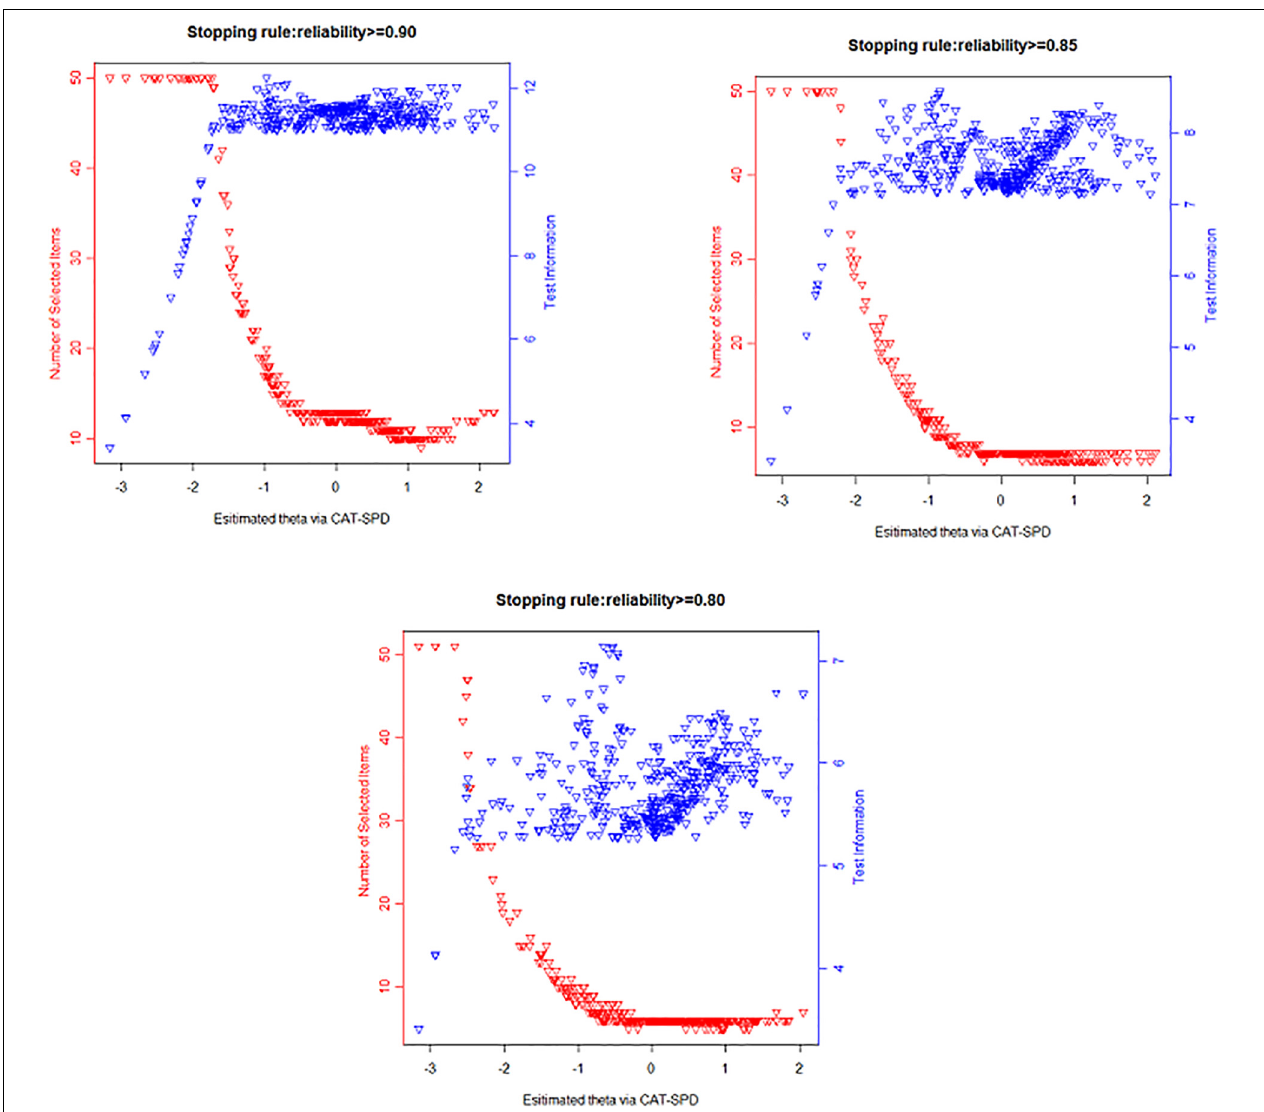
FIGURE 2 | Number of administrated items and test information curve under different stopping